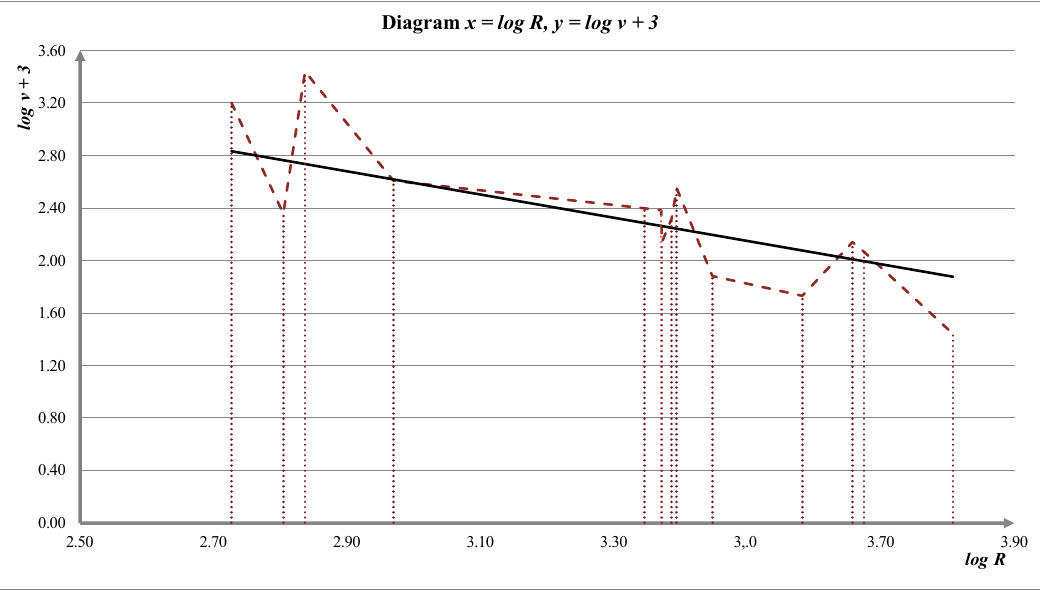
Figure 5. Graphic representation of values logR and logv + 3 for calculating the parameters in Nepri č ava open pit.